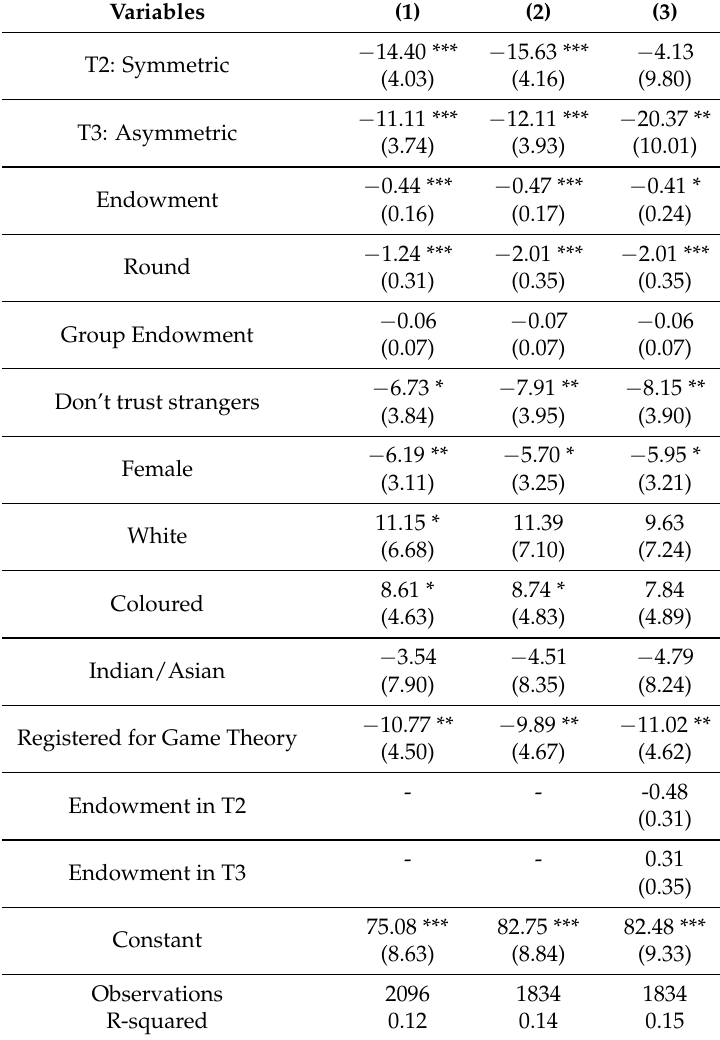
Table A1. Expanded Treatment Effects of Aggregate Social